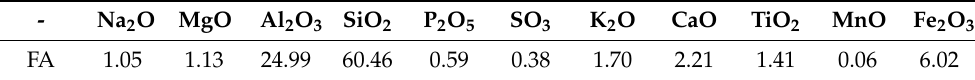
Table 5. Chemical composition of FA obtained with PARC